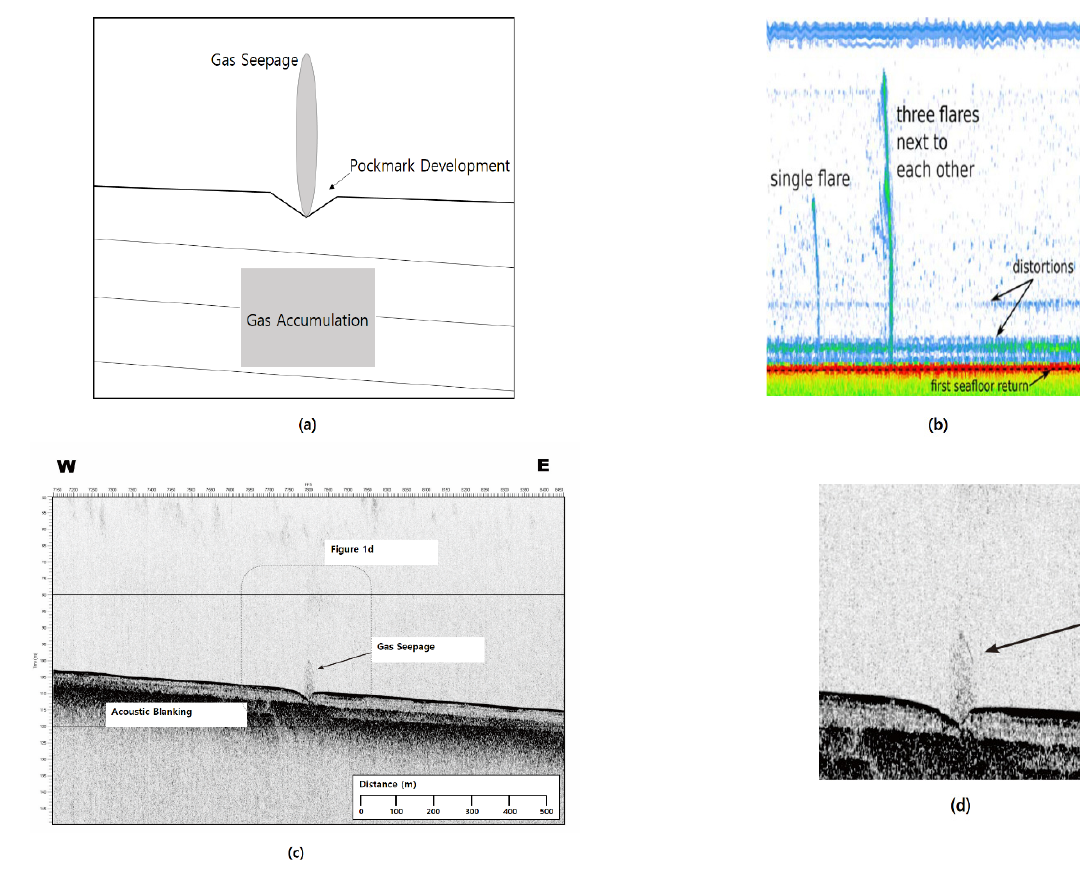
Figure 1. Aspects and observations of AFs: ( a ) schematic diagram of gas seepage above pockmark (modified from Dondurur et al. (2011) [13]); ( b ) AFs recorded on the vertical section by multi-beam echo-sounder survey (reprinted with permission from Urban et al. (2017). This figure is a derivative of [21], used under CC BY 4.0 [link to https://creativecommons.org/licenses/by/4.0/), Accessed: 16 September 2022]; ( c ) AFs recorded by Chirp sub-bottom profiler survey; ( d ) enlarged gas seepage in ( c ).